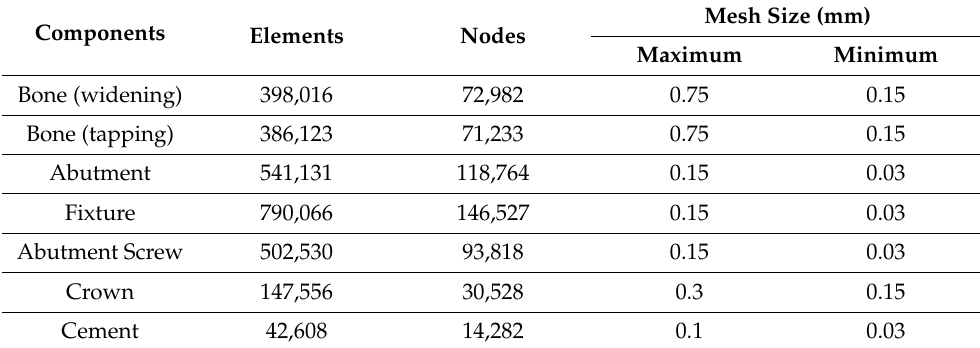
Table 3. Number of nodes and elements and mesh sizes of the